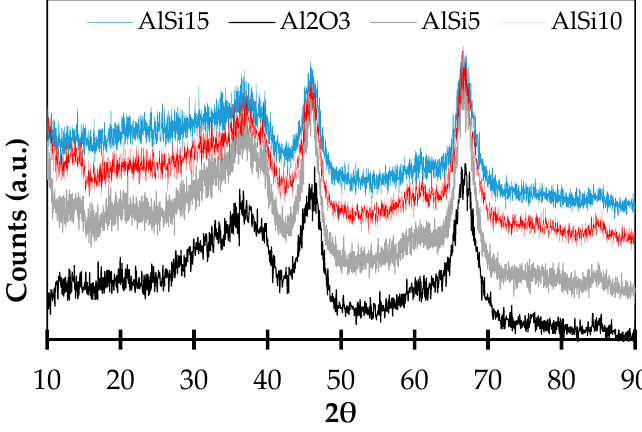
Figure 2. XRD Diffractograms of powder catalysts AlSix, where x is 5, 10 and 15 mol % of silica.